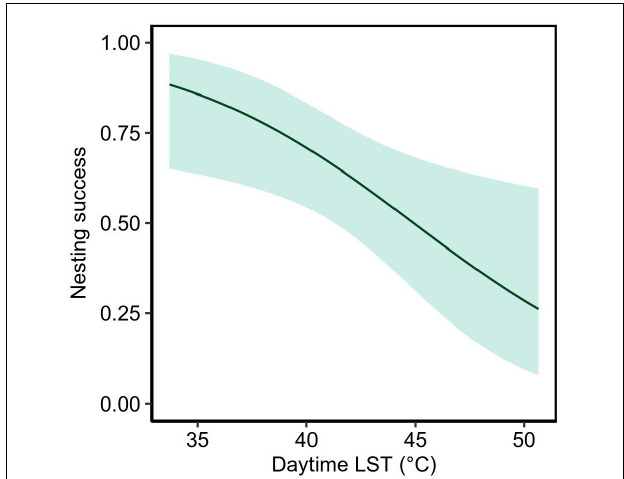
FIGURE 6 | Nesting success (probability of successful nesting per emergence to the beach) in response to the land surface temperature (LST) during a day of each nesting event. The solid line represents the estimated relationship and the band shows the 95% confidence